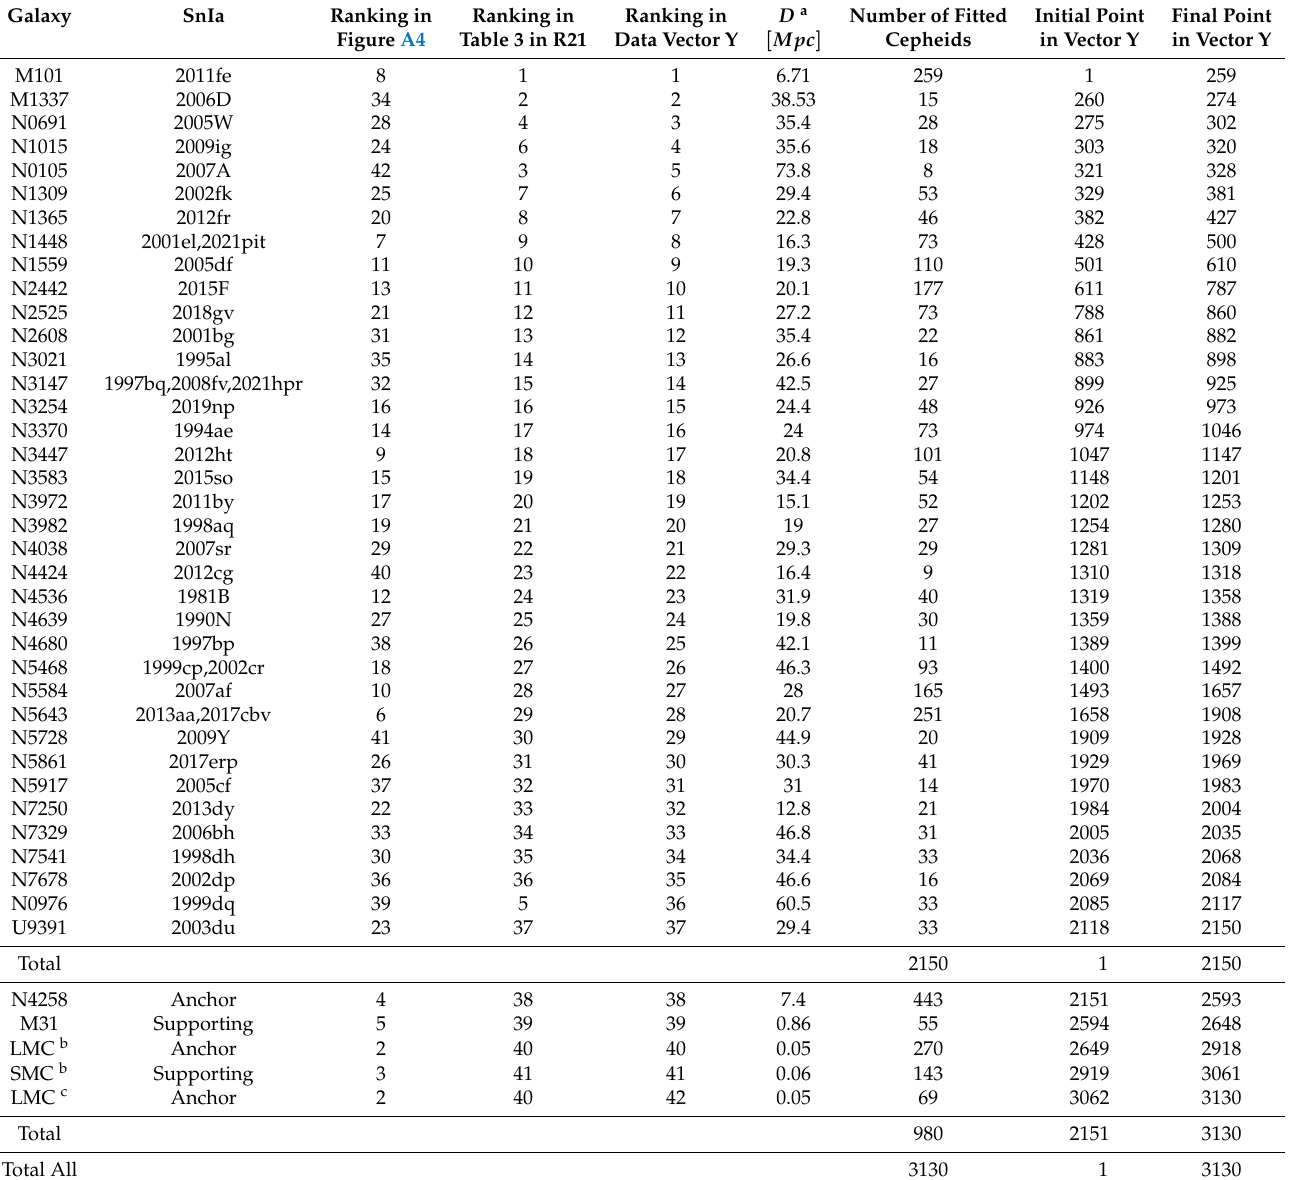
Table 3. Properties of the Cepheid hosts considered in the